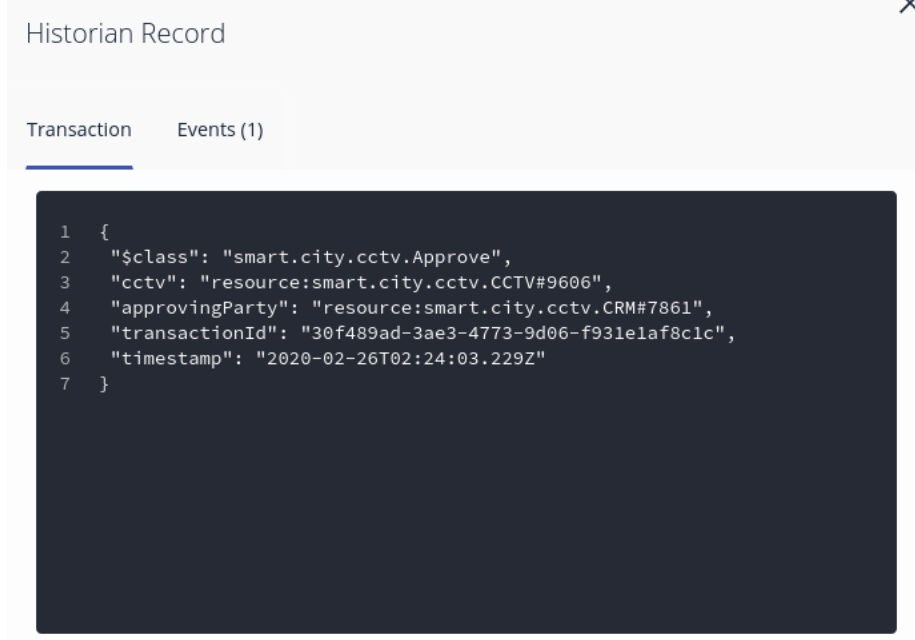
Figure 13. Record of transaction history.